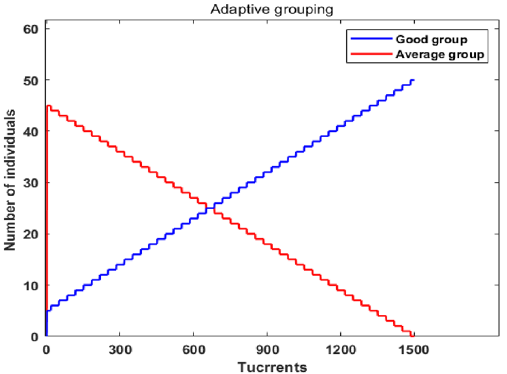
Figure 2. Individual number of students in the two groups